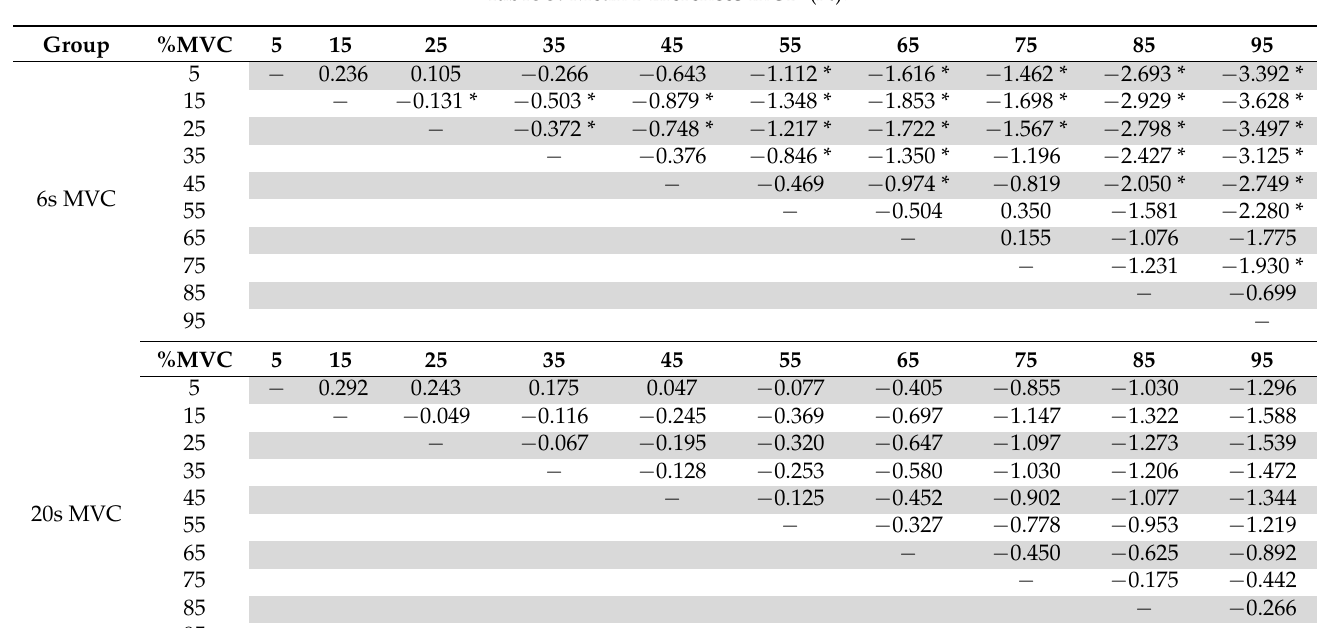
Table 3. Mean Differences in SD (N).